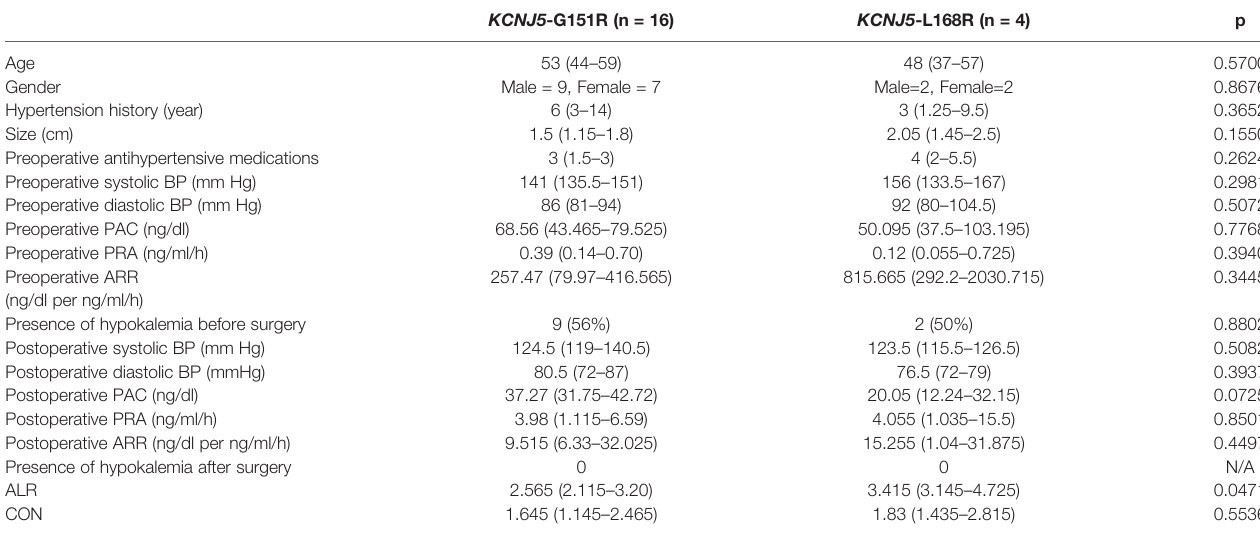
TABLE 2 | Characteristics of clinical and NP-59 adrenal scintigraphy regarding to different point mutation of KCNJ5